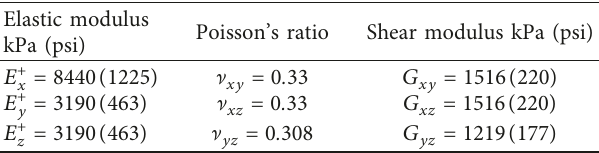
Table 2: Material properties used for modeling the poly- isocyanurate